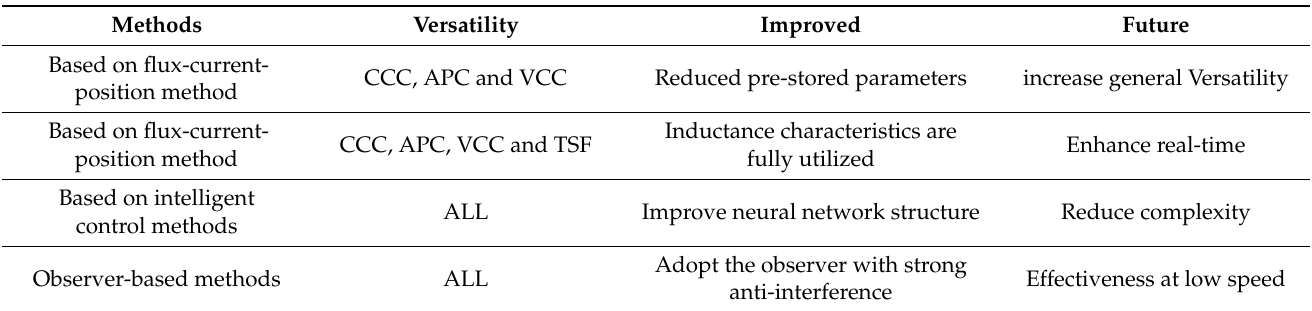
Table 1. Prediction of the development of existing methods.